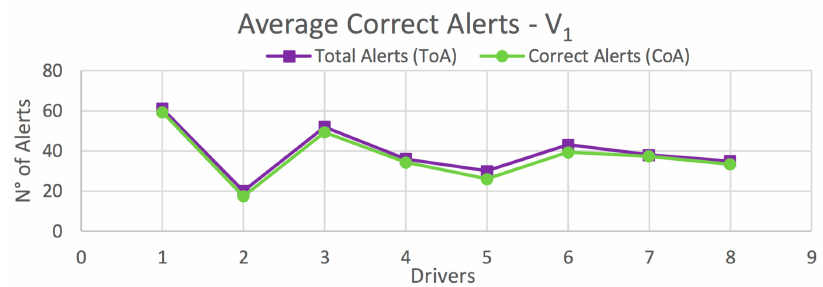
Figure 12. Average total correct alerts on all routes for V 1 (Light Vehicle).